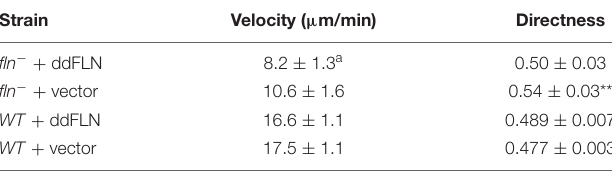
TABLE 1 | Random migration of fln − and wild-type cells expressing mCherry-tagged ddFLN or empty vector. Strain